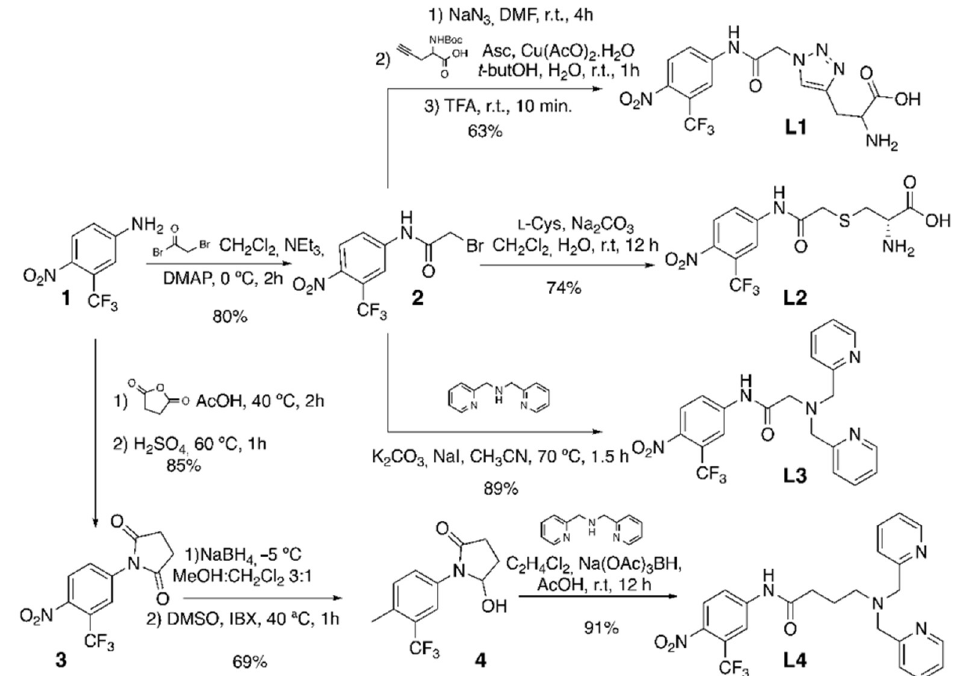
Scheme 1. Synthetic schemes for ligands L1 – L4